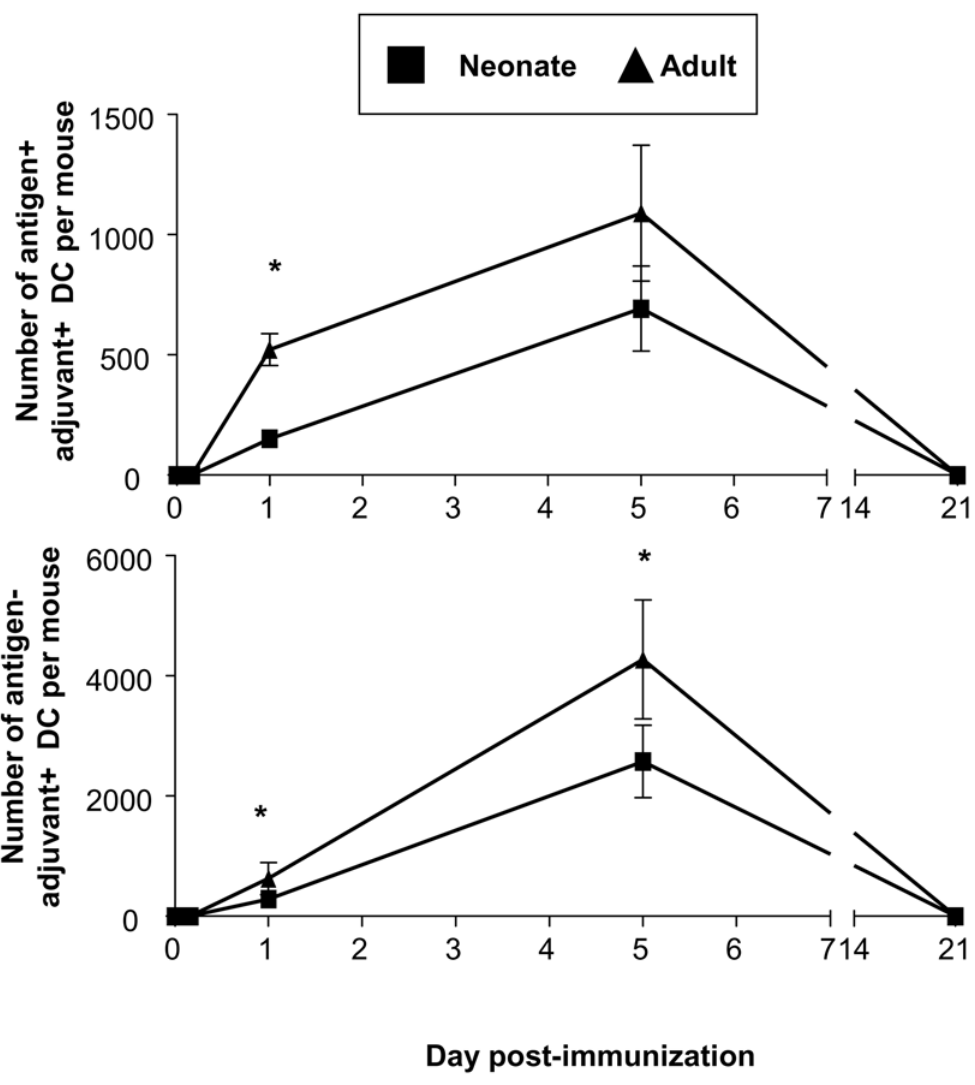
Figure 5. Kinetics of Ag85B-ESAT-6 and CAF01 labeled DC in the draining LN of adults and neonates. At various time points after immunization, the number of Ag85-ESAT-6 + CAF01 + DC and Ag85-ESAT-6 2 CAF01 + DC was calculated. The data are expressed as mean and SD of groups of at least 4 individual mice. *, p , 0.05 signifies differences between neonates and adult mice.